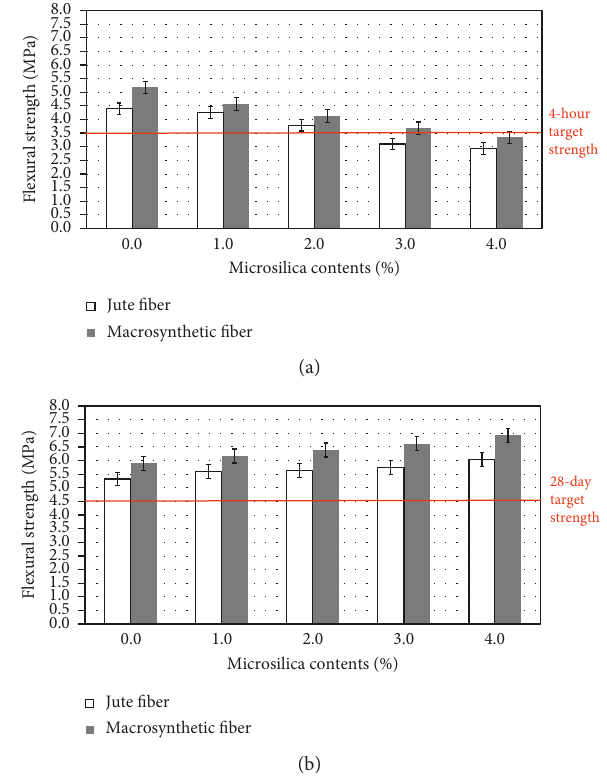
Figure 6: Flexural strength of LMFRCRSC. (a) 4-hour curing. (b) 28-day curing.